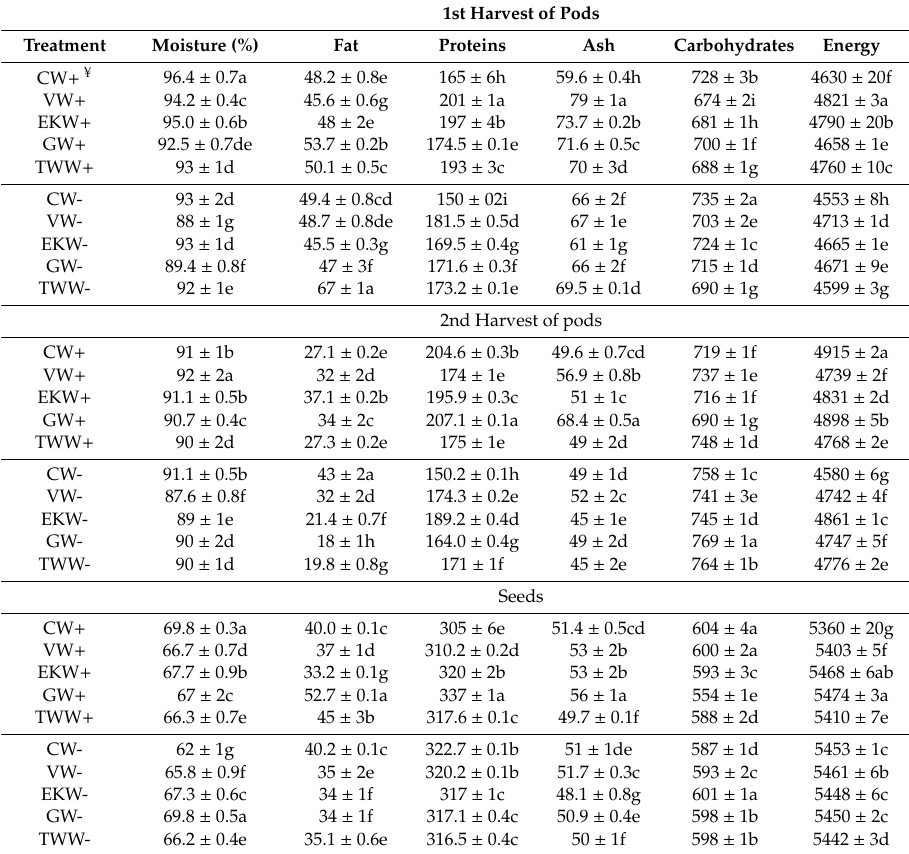
Table 3. Nutritional (g / kg dw) and energetic value (kcal / kg dw) of the studied pods and seeds of beans in relation to irrigation regime (mean ± SD). 1st Harvest of